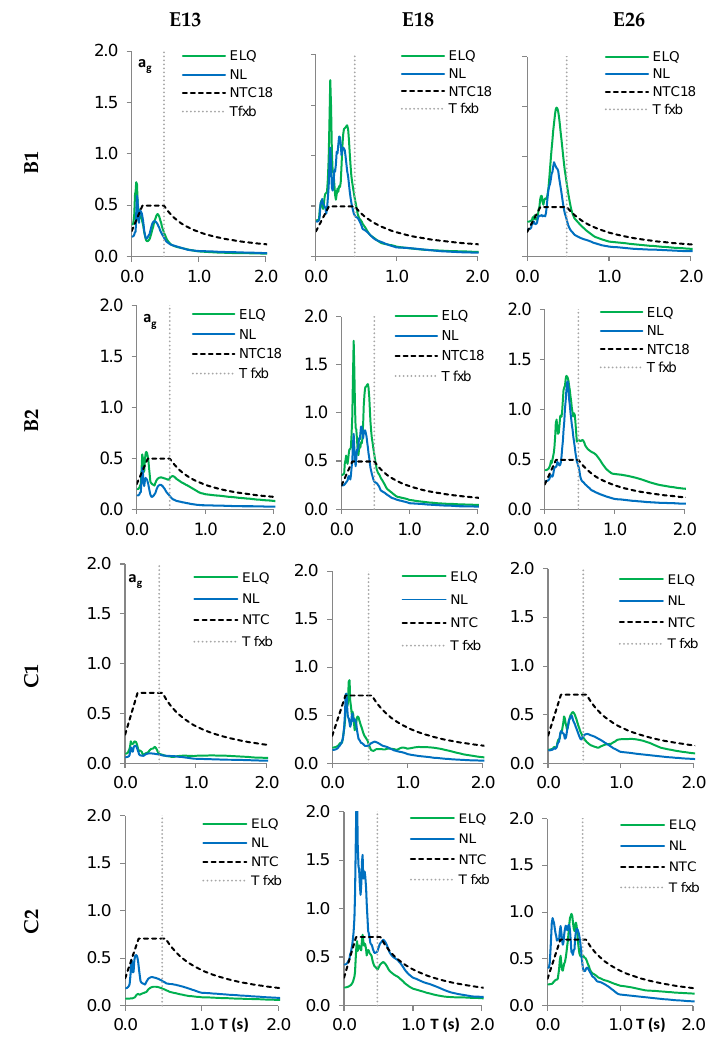
Figure 21. Comparison between response spectra at the base of the structure obtained by the two di ff erent constitutive models (ELQ vs. NL) and provided by [24].